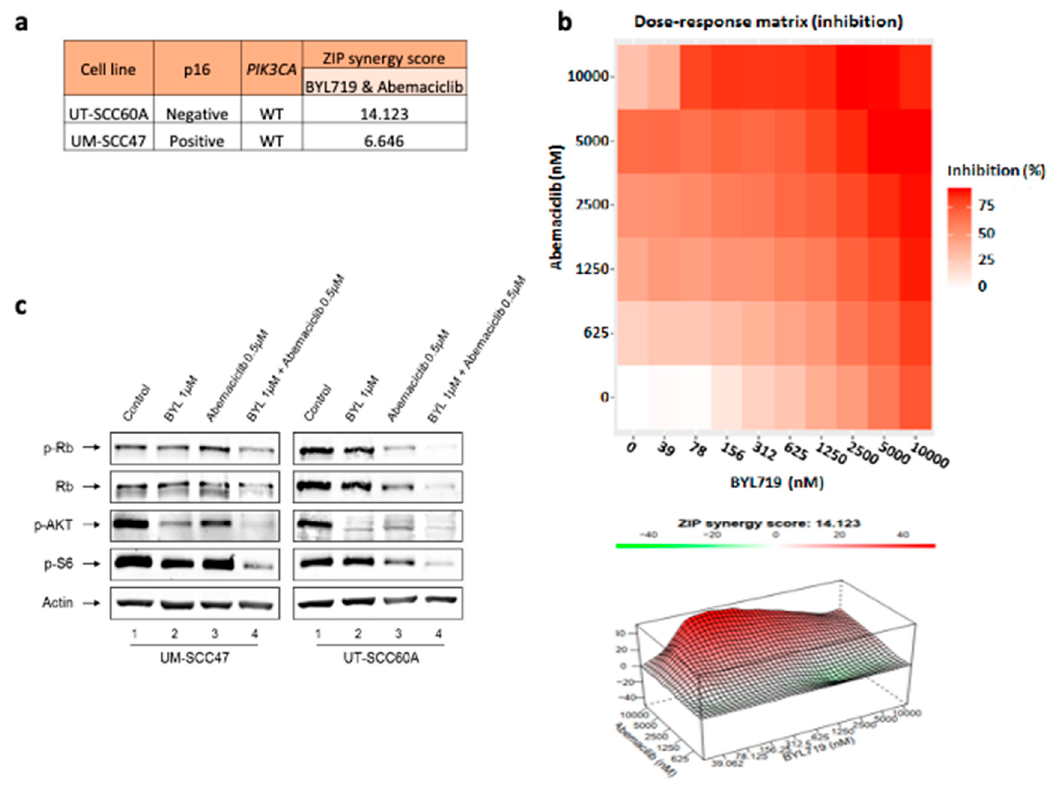
Figure 4. Combination treatment with PI3K and CDK 4/6 inhibitors display a synergistic effect in PIK3CA -WT tumors. ( a ) Average ZIP synergy scores, calculated by SynergyFinder 2.0, of UT-SCC60A and UM-SCC47 following treatment with a combination of abemaciclib and BYL719. ( b ) Dose–response matrix and ZIP synergy score surface plots of UT-SCC60A following treatment with a combination of BYL719 and abemaciclib. ( c ) Signaling pathway protein expression in UM-SCC47 and